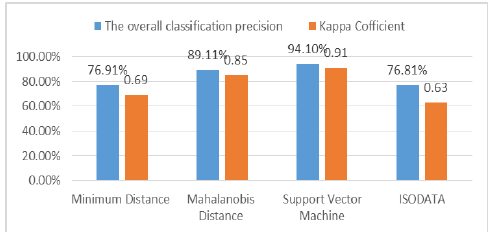
Figure 5. The overall classification precision and Kappa coefficients of the four kinds of